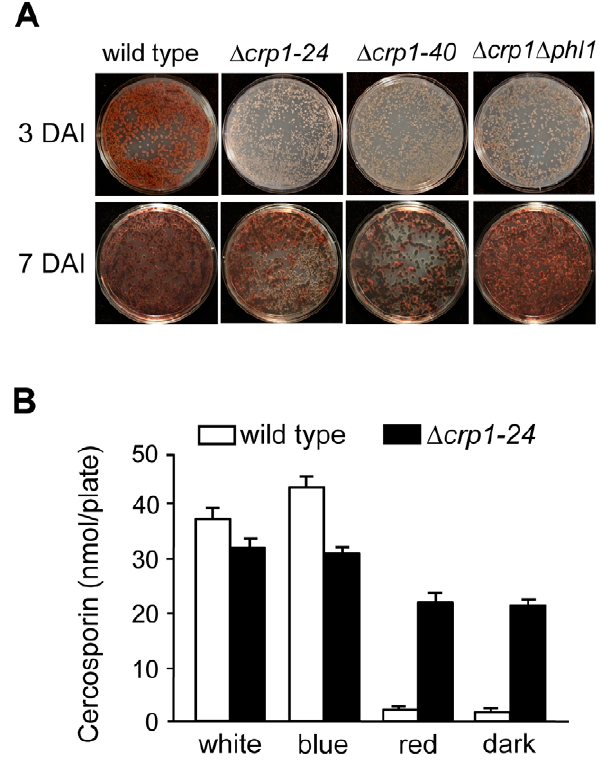
Figure 8. Disruption of CRP1 affects cercosporin biosynthesis. A, Conidia (10 5 ) were spread on 0.2 6 PDA, and incubated for three days and seven days in constant white light. DAI=days after inoculation. B, Quantification of cercosporin biosynthesis in various light conditions. Cercosporin was measured from wild type and D crp1-24 cultures grown on 0.2 6 PDA in constant white, blue, red light and darkness for seven days.